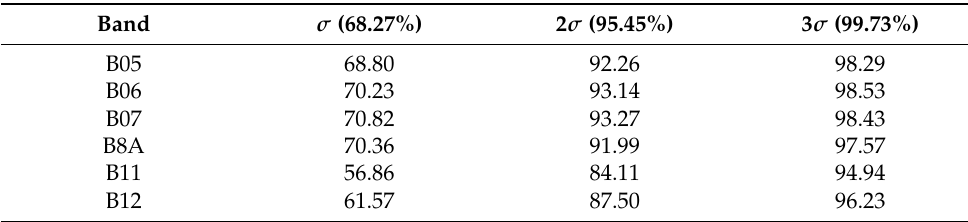
Table 13. Probability of the absolute error being lower than n × σ (L1C).